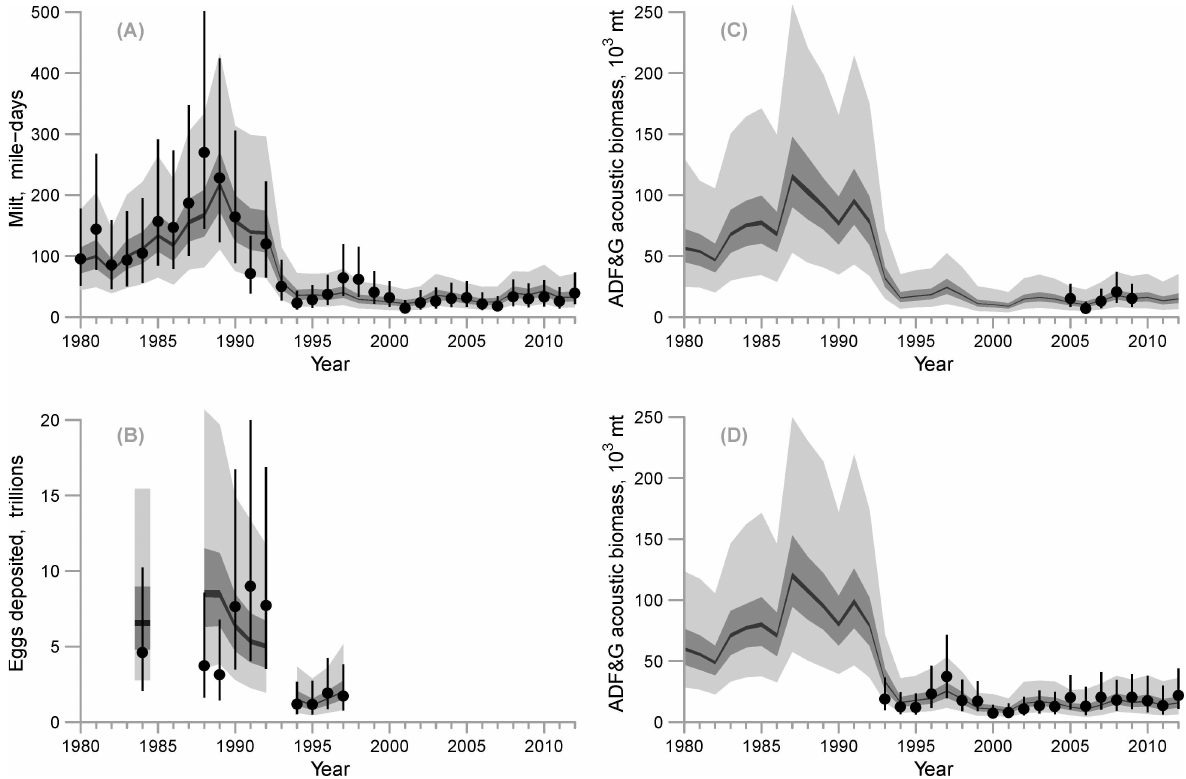
Fig 5. Model estimates and the four time series of abundance estimates (1980–2012): (A) mile-days of milt, (B) egg depositionsurveys, (C) ADF&G hydroacoustic estimates, and (D) PWSSC hydroacoustic estimates. The solid circles and lines represent the mean and 95% confidenceintervalsof the data (plus additional variance estimated by the model); the shaded polygons represent the respectiveposterior predictiveintervals (light gray = 95% interval, darker gray = 50% interval, black = 5% interval).